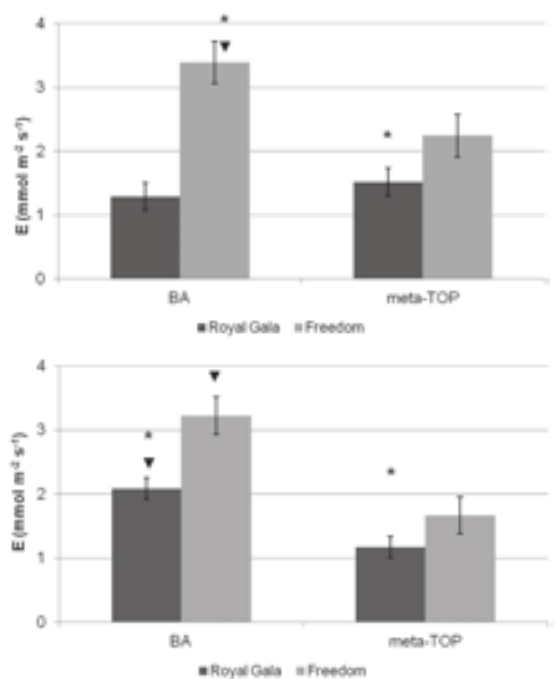
Figure 3. Effects of different cytokinins and apple cultivars on rate of transpiration (E) at (A) 2.0 µM and (B) 6.0 µM cytokinin supply. *: means significant (P ≤ 0.05) differences between the apple scion cultivars (‘Royal Gala’ and ‘Freedom’) at the same cytokinin type; ▼ : means significant (P ≤ 0.05) differences between the cytokinin types (BA and meta-TOP) in the same scion cultivar